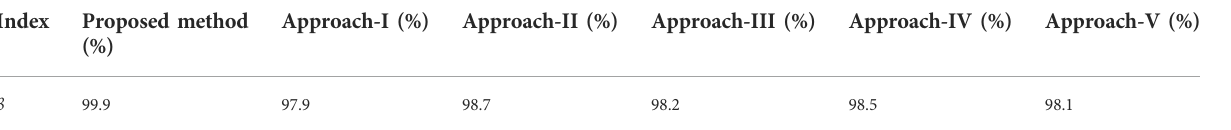
TABLE 3 Comparison of various power allocation approaches.